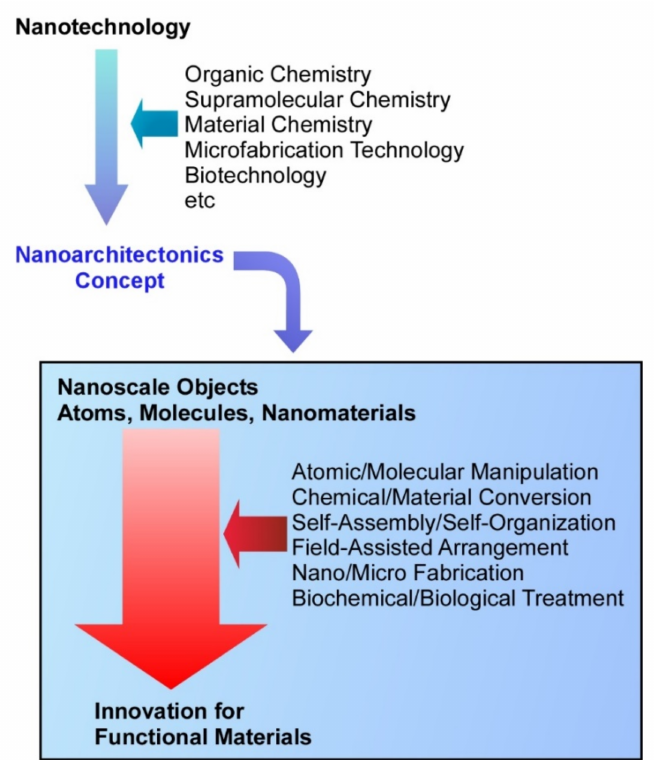
Figure 1. A post-nanotechnology concept, nanoarchitectonics, aiming to fabricate functional